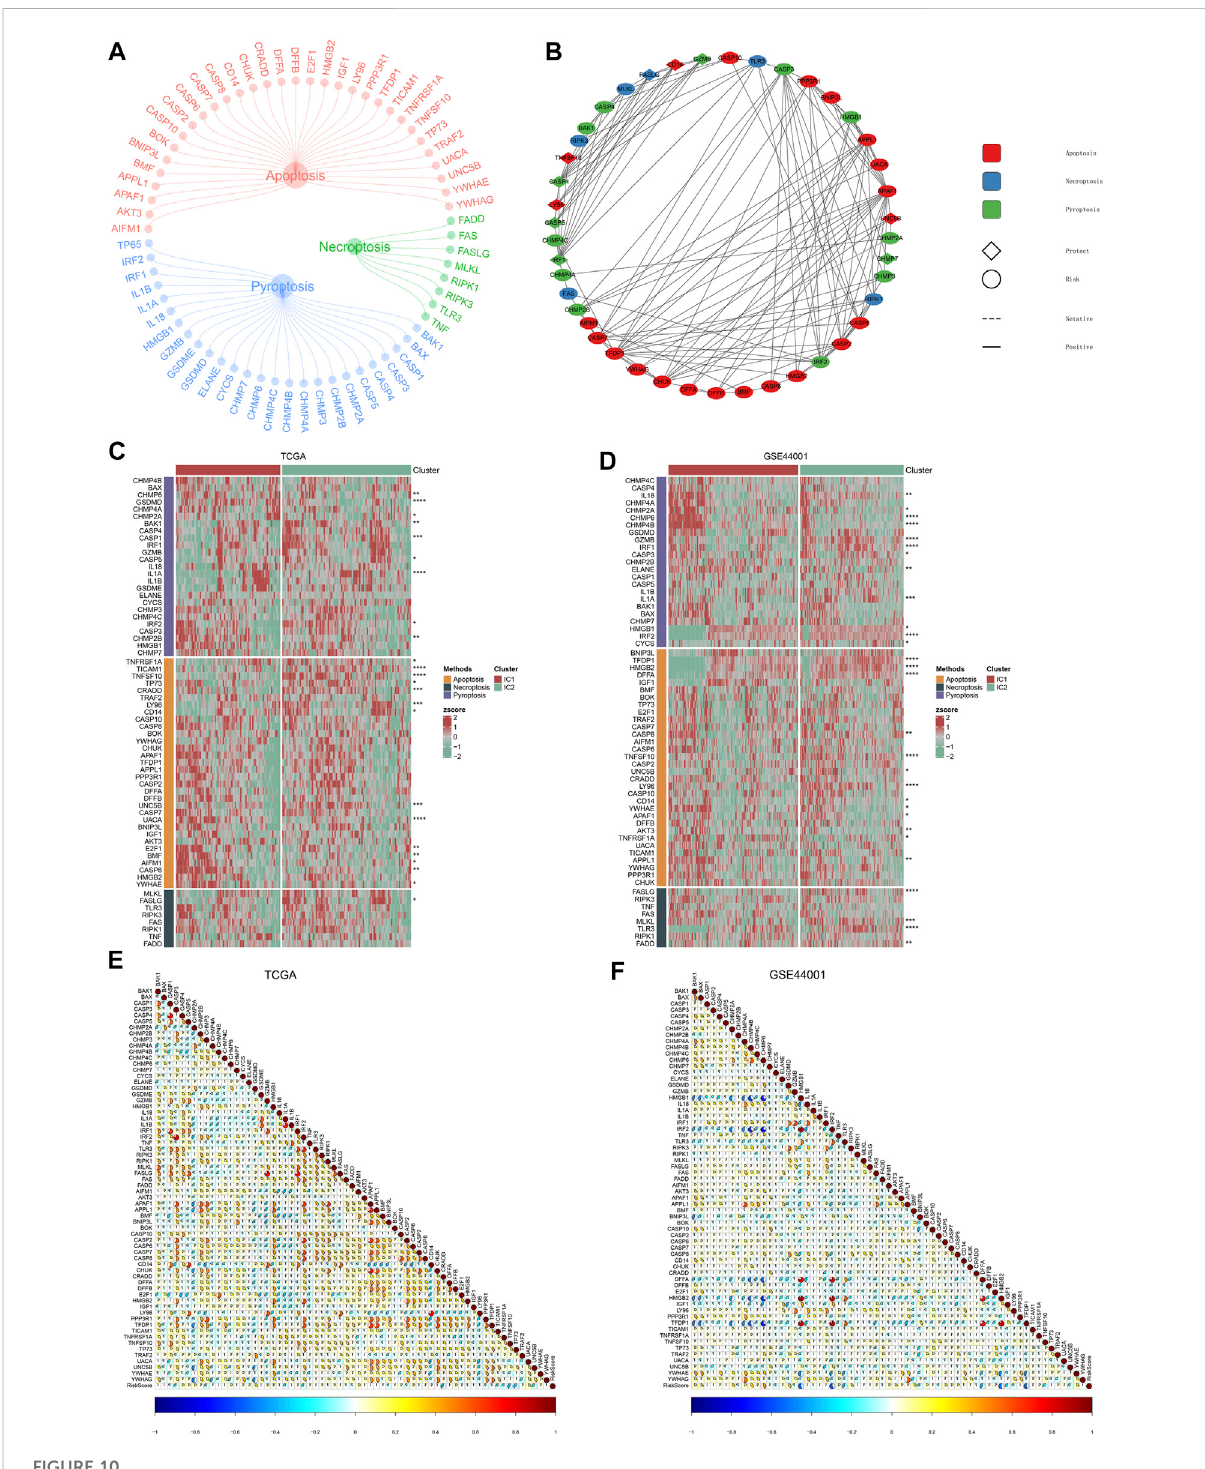
FIGURE 10 PANoptosis features of immune subtypes and immune subtype-relevant recurrence model. (A) The network of PANoptosis (pyroptosis, apoptosis,andnecroptosis)genes. (B) Prognosticsigni fi canceofPANoptosisgenesandtheirinteractions. (C,D) Heatmapsoftheexpressionpatterns of PANoptosis genes across two subtypes. (E,F) Correlations between immune subtype-relevant recurrence model-derived risk score and PANoptosis genes (* p < 0.05; ** p < 0.01; *** p < 0.001; **** p <